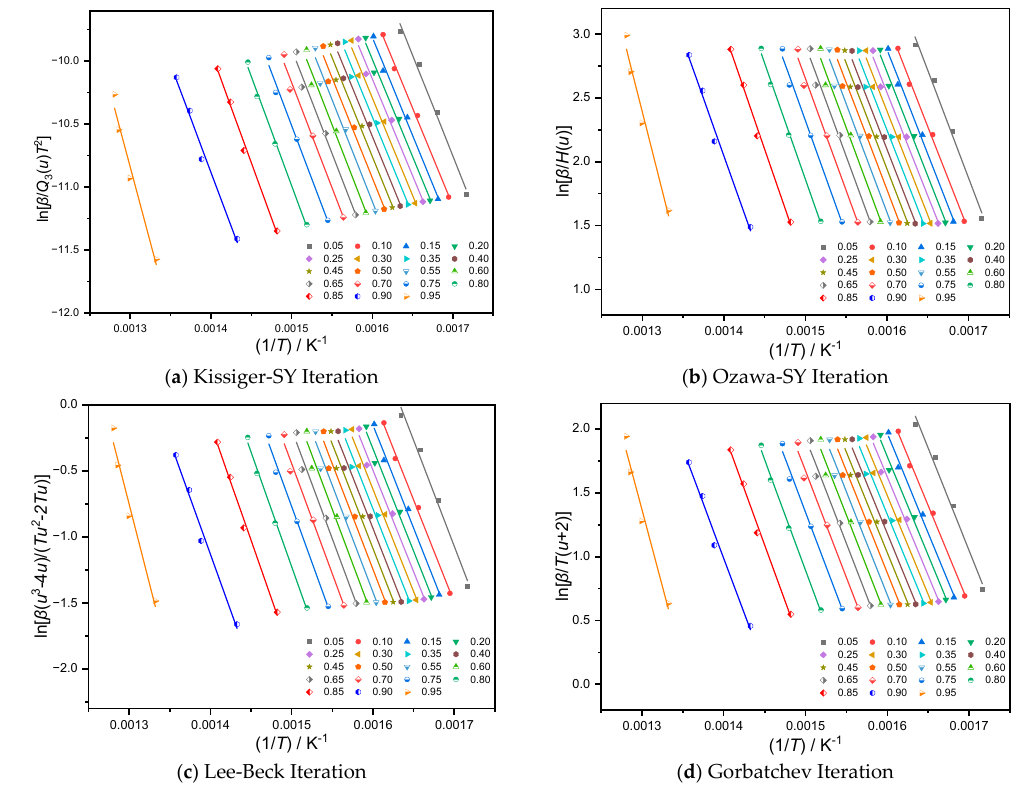
Figure 2. linear regression fitting diagram of the equal conversion method of Al-lignin, based on four temperature approximations.